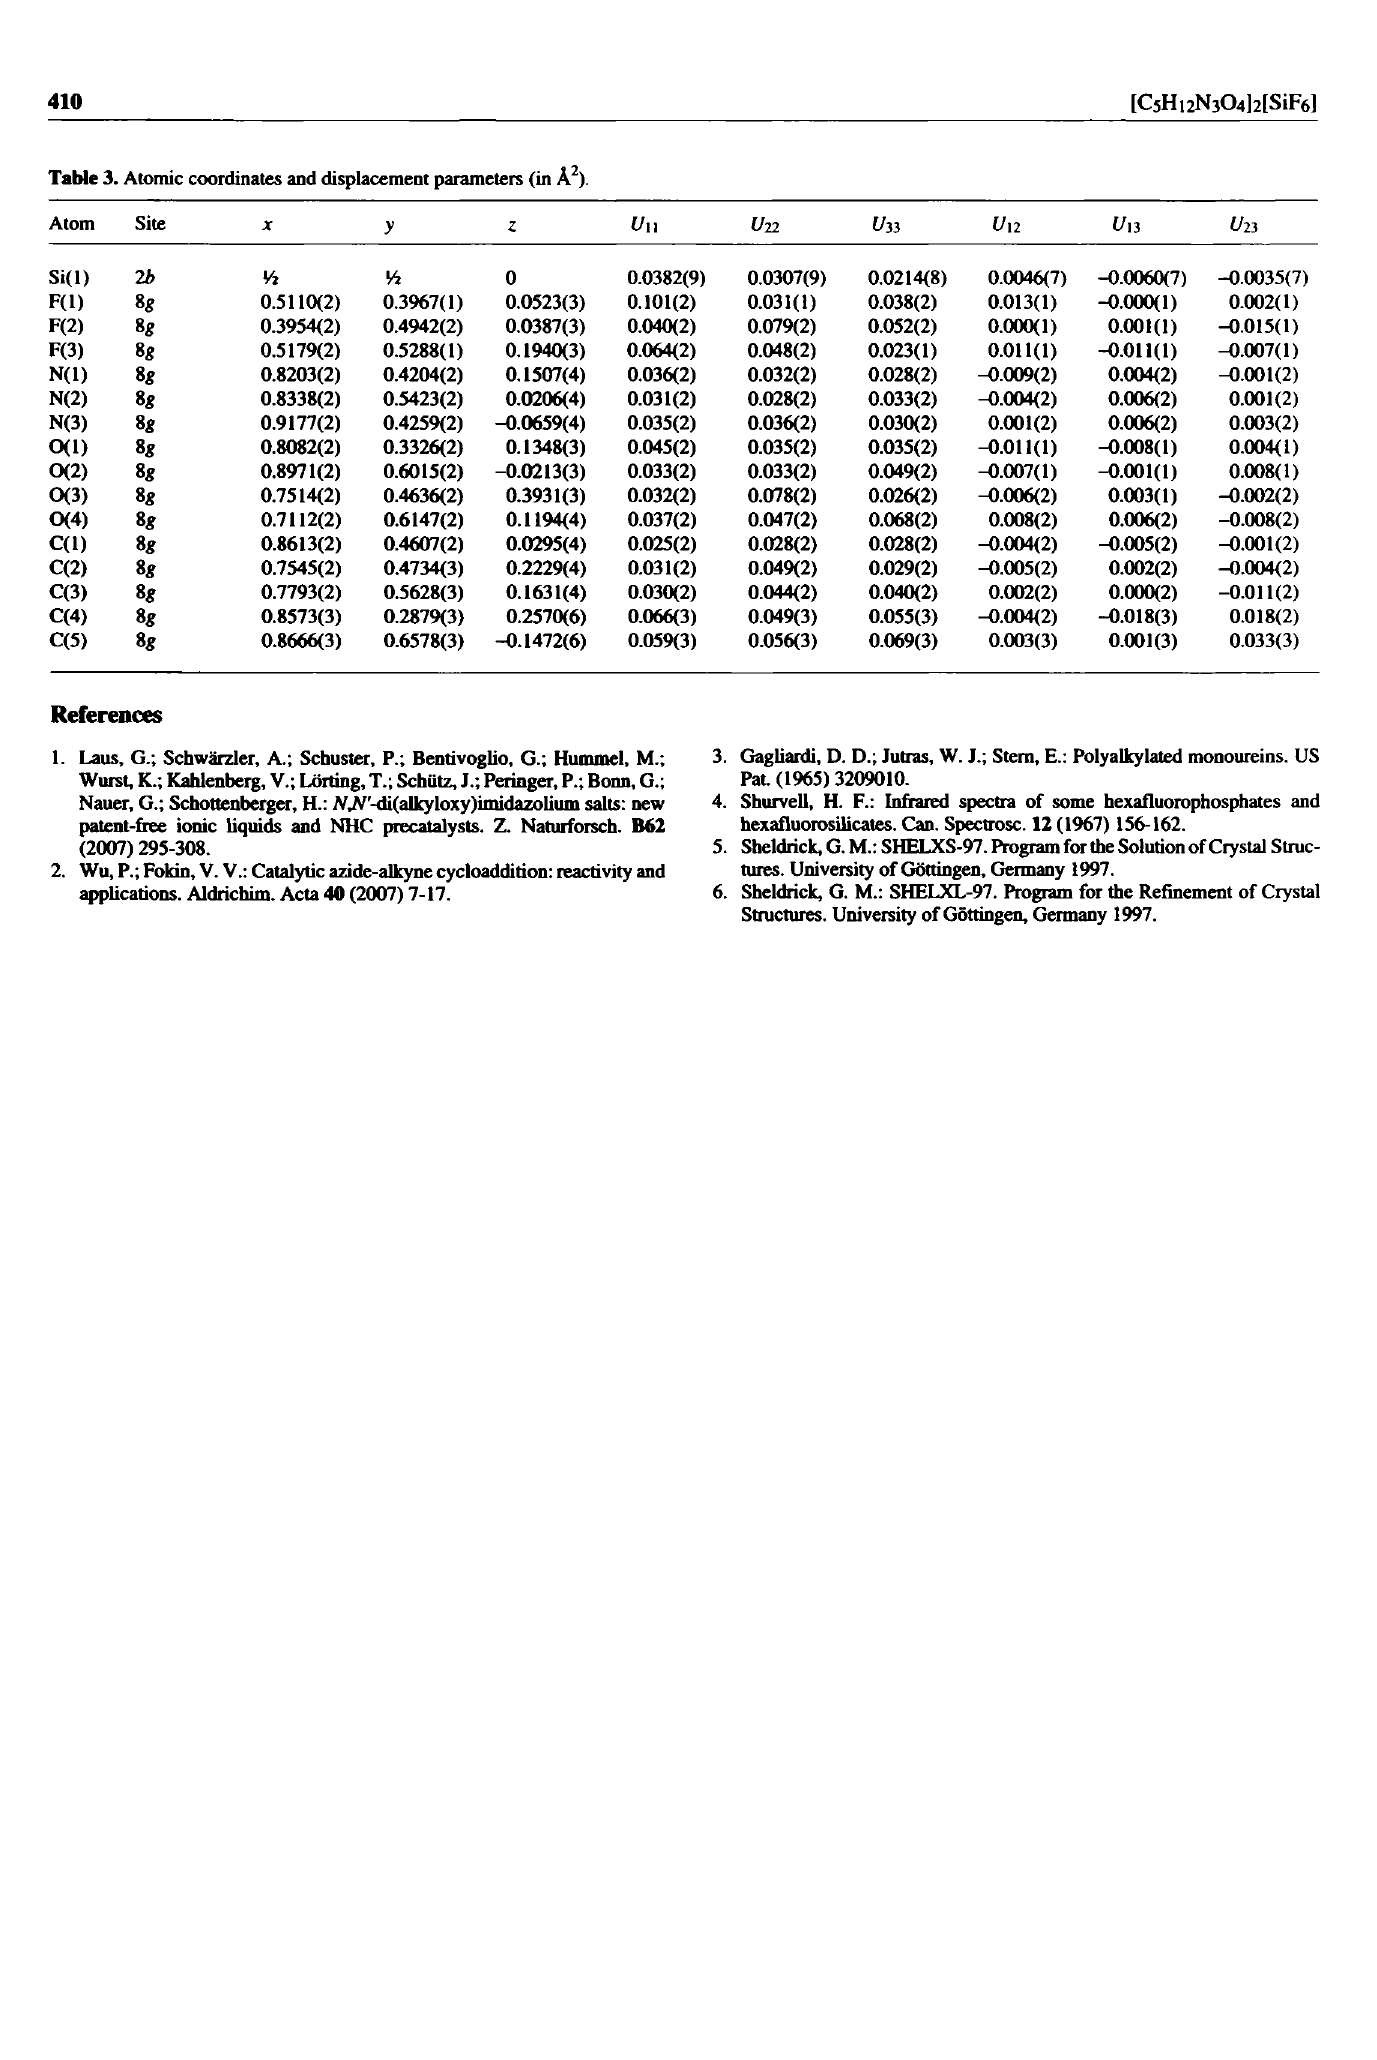
Table 3. Atomic coordinates and displacement parameters (in Â 2